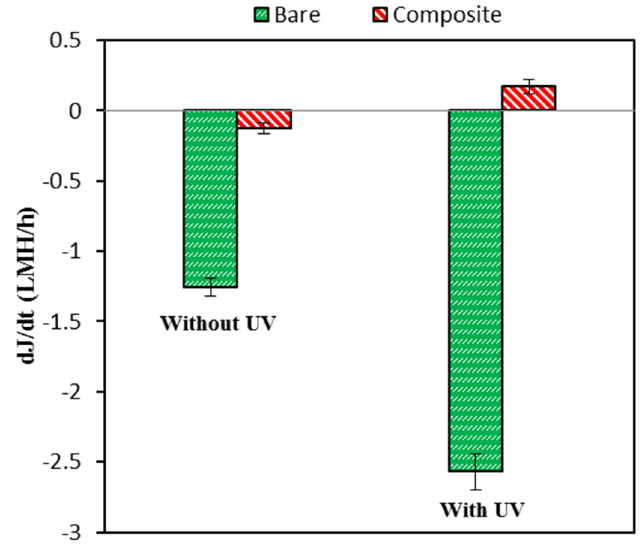
Figure 8. Comparison of the membrane fouling rate for the bare Al 2 O 3 membrane and Poly(oxyethylene methacrylate) (POEM)-directed TiO 2 /Al 2 O 3 composite membrane during filtration in the presence (With UV) and absence (Without UV) of ultraviolet (UV) illumination (filtration time: 24 h).